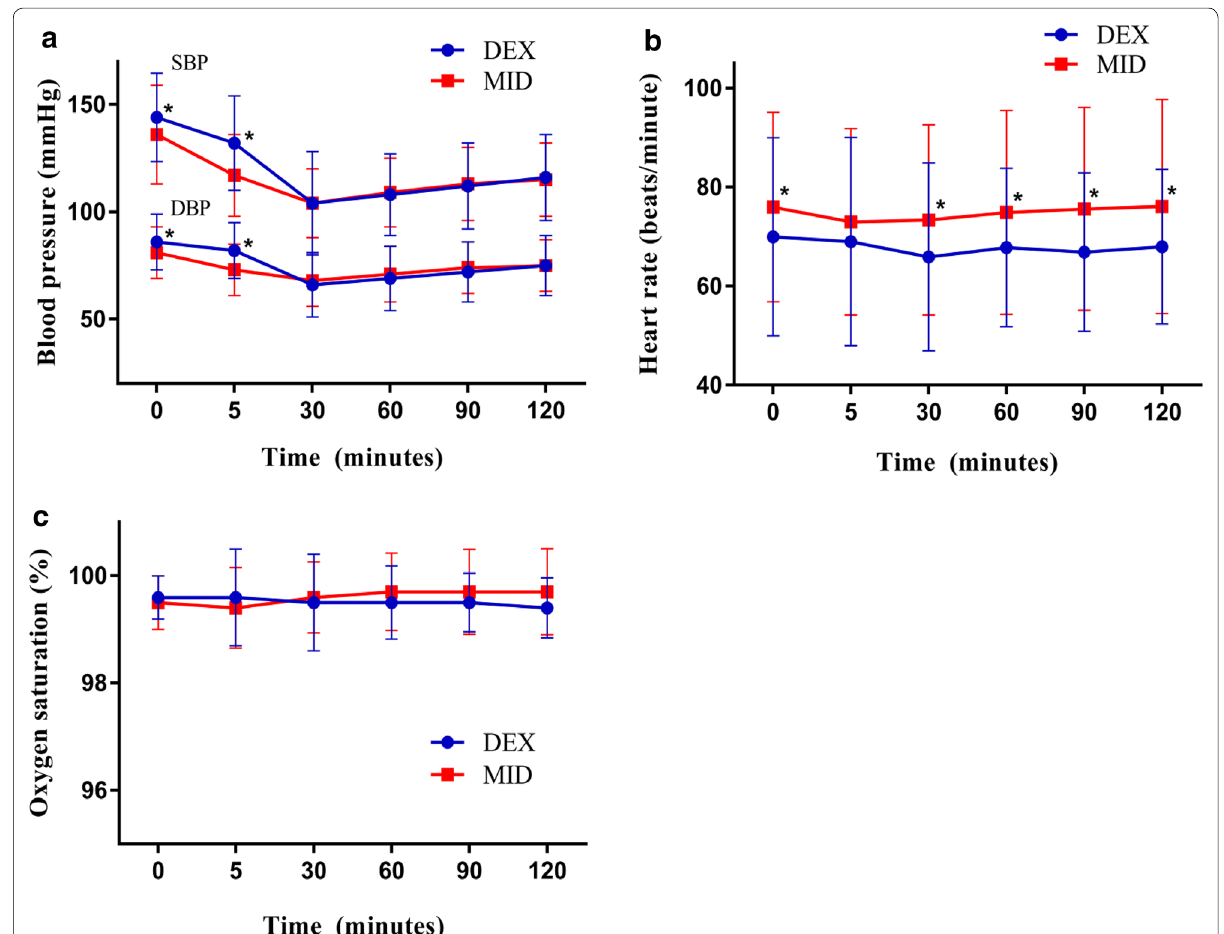
Fig. 1 Changes in the mean SBP and DBP ( a ), heart rate ( b ), and peripheral oxygen saturation ( c ) during radiofrequency catheter ablation for atrial fibrillation in the two groups. * p < 0.05 between the two groups at the time point. SBP: systolic blood pressure, DBP: diastolic blood pressure, DEX: dexmedetomidine remifentanil, MID: midazolam fentanyl + +